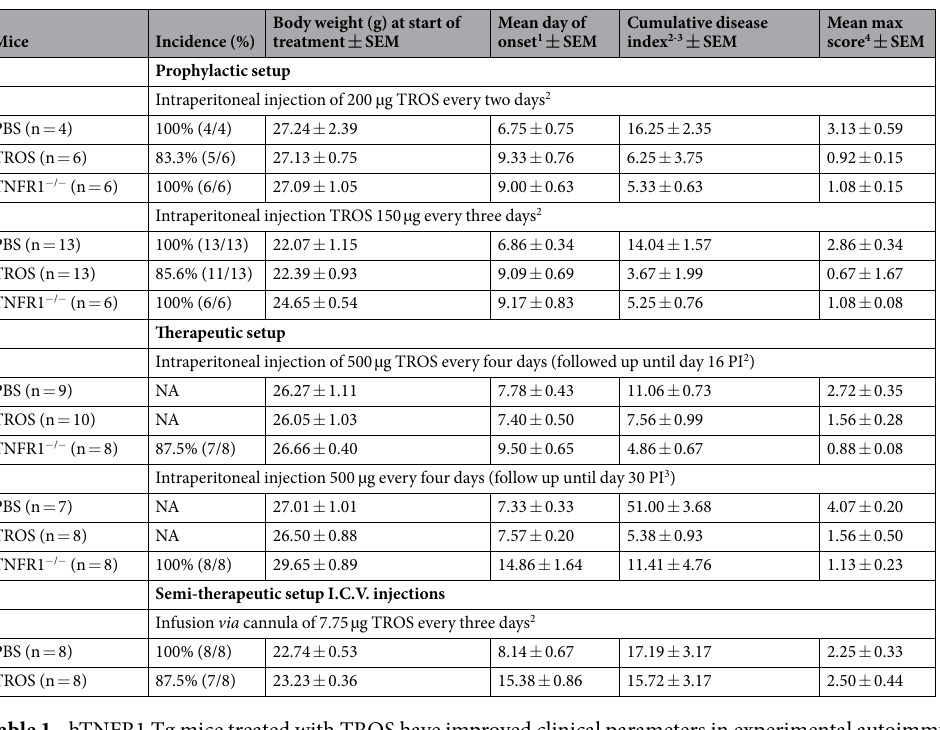
Table 1. hTNFR1 Tg mice treated with TROS have improved clinical parameters in experimental autoimmune encephalomyelitis (EAE) similar to TNFR1 − / − mice. The disease score for each mouse was recorded daily based on the following classification: 0, no clinical disease; 1, weakness of tail; 2, complete loss of tail tonicity; 3, partial hind limb paralysis; 4, complete hind limb paralysis; 5, forelimb paralysis or moribund; 6, death. Intermediate scores were given when necessary. 1 Mean day of disease onset ( ± SEM) is defined as the day of clinical symptoms for two consecutive days. 2,3 Cumulative disease index ( ± SEM) was calculated by summing the daily clinical scores and divided by the number of animals per group. It was determined 16 days post-immunization 2 or 30 days post-immunization 3 . 4 Mean score ( ± SEM) when mice reached maximal clinical symptoms. NA = Not applicable, PI: post-immunization